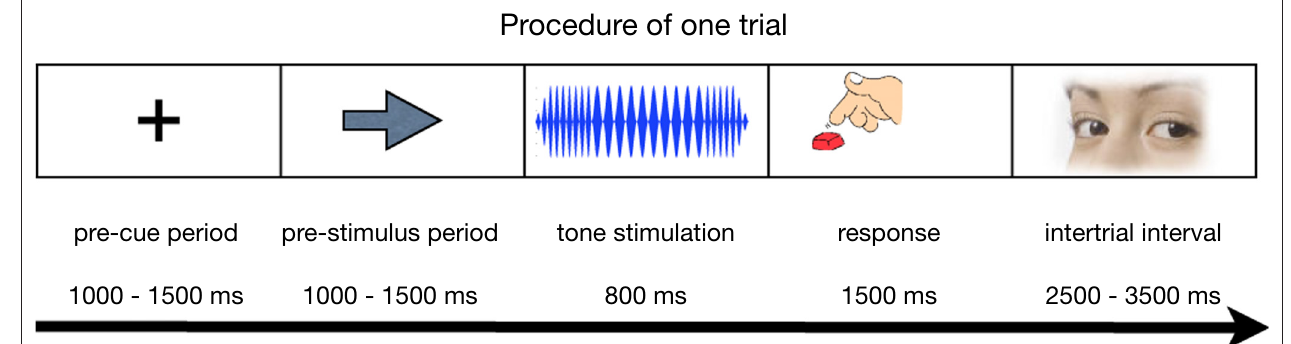
FIGURE 1 | Illustration of a target trial used in the